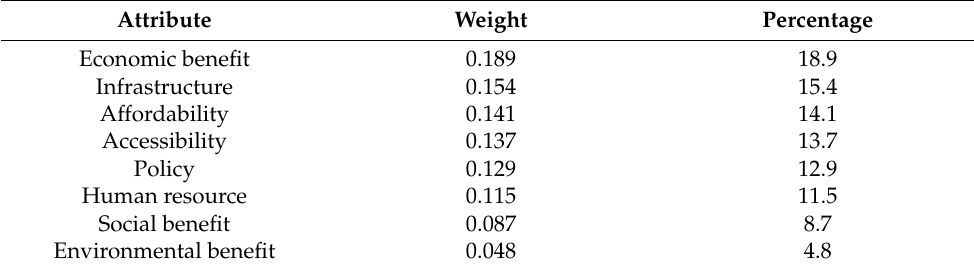
Table 6. Weights assigned to the eight criteria using analytical hierarchy process